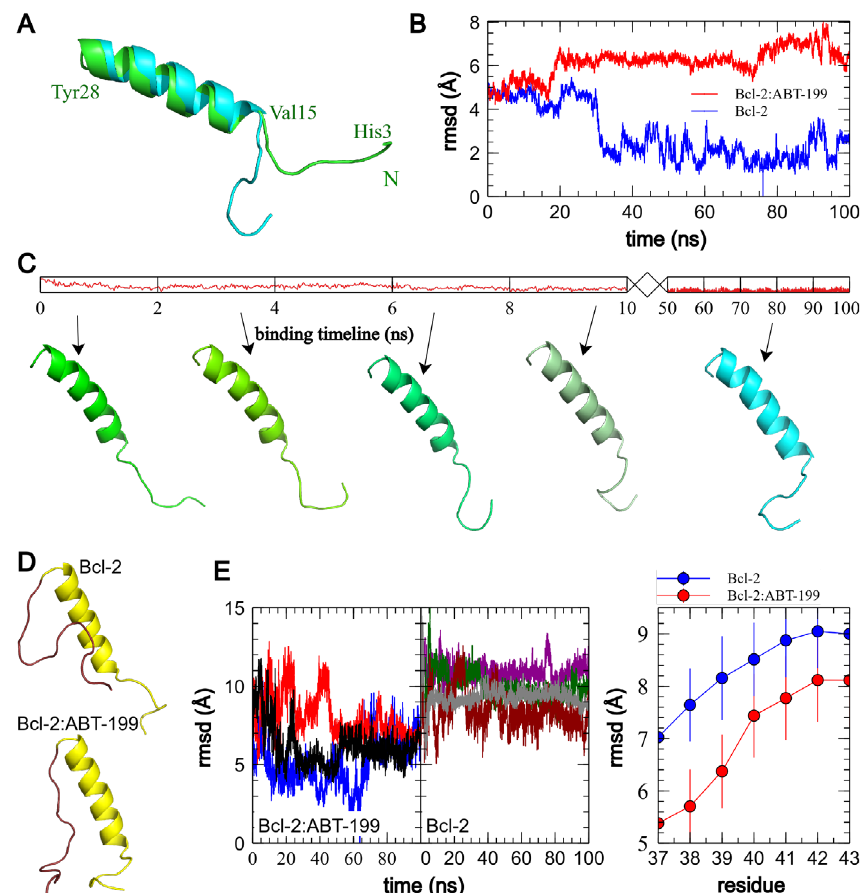
Figure 5. ABT-199 binding to Bcl-2 induces an N-terminal tail-flip event and rearranges the Bcl-2 loop. (A). Comparison of the median structures of the principal clusters of BH4 domain structures in free Bcl-2 post equilibration (green backbone) and ABT-199 bound Bcl-2 following the binding event (cyan backbone). N-terminus of Bcl-2 is denoted with the green letter N, and endpoints and α-helix of the represented fragment are marked in green with corresponding residue labels. Note the stabilized “tail-flipped” configuration of the BH4 domain in the ABT-199 bound structure. (B). rmsd variation in the BH4 domain of the Bcl-2 alone and interacting with ABT-199. Note the small deviation from the most common structure of the free Bcl-2 after a short equilibration period, compared to a significantly larger mean rmsd in ABT-199 bound Bcl-2 following a noticeably longer period of propagation of the conformational change post the onset of the binding. (C). Representative frames illustrating the propagation of the conformational change following the onset of ABT-199 binding. (D). Comparison of Bcl-2 fragment median structures, including BH4 and loop domains in Bcl-2 alone (top) and Bcl-2:ABT-199 complex (bottom). Note the realignment of the loop fragment immediately adjacent to BH4. (E). Individual plots of rmsd of the first 10 residues of the Bcl-2 loop (residues 29–39) with regard to median structures of the Bcl:ABT complex (left) and, evolution of average rmsd values as a function of loop fragment length, indexed by the last residue (right). Note significantly smaller deviations of the Bcl:ABT complex loop fragments up to residue 39, representative of the loop region adhering to the BH4